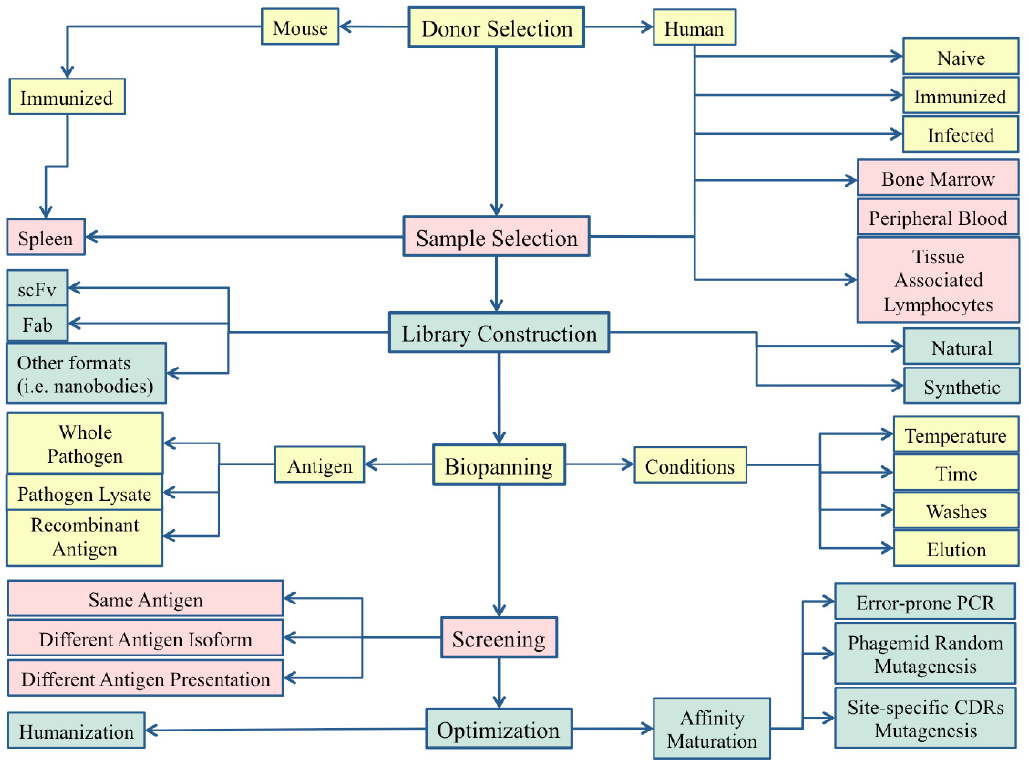
Figure 1. Crossroads representing the different decisional schemes used for the successful monoclonal antibodies (mAbs) molecular cloning described in the